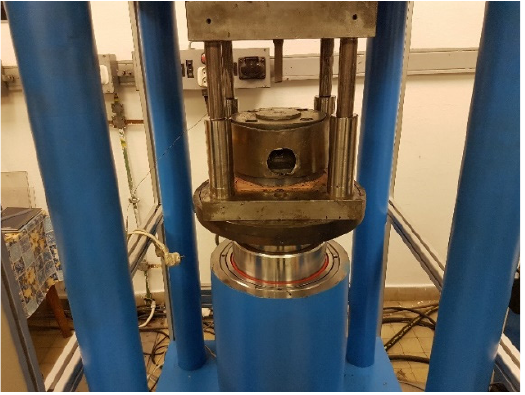
Figure 1. View of the workstation for material forming using the ECAP